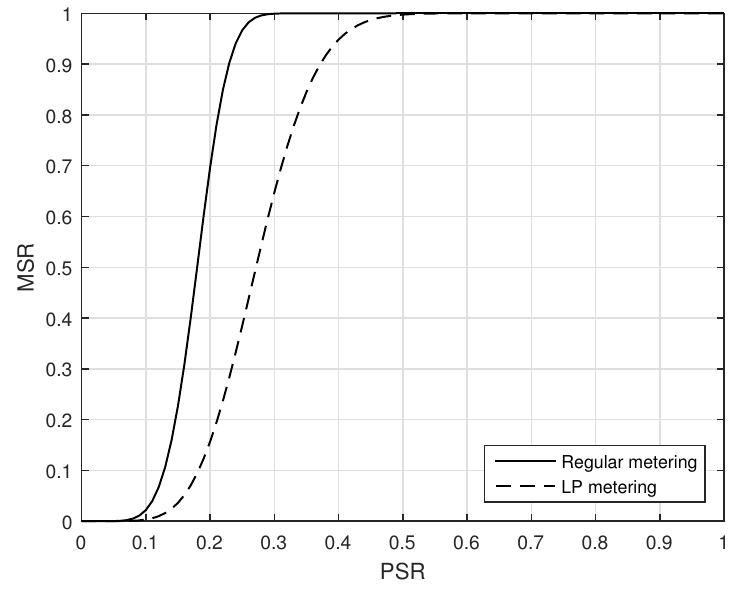
Figure 15. Metering success